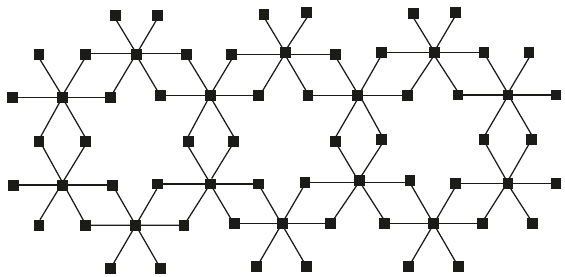
Figure 2: Chain for m � 3 (bismuth